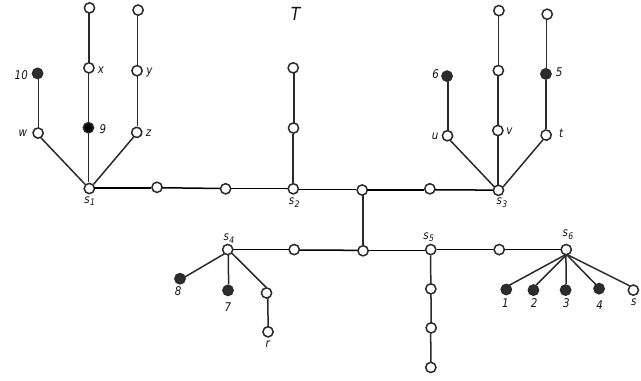
Figure 2. The tree example T with β ( T ) = 10 and β (cid:48) ( T ) = 14. For y ∈ V Γ and f = ab ∈ E Γ , the vertex-edge metric/distance is determined as d ( y , f ) : = min { d ( a , y ) , d ( b , y ) } . A vertex y ∈ V Γ is known to resolve two edges f , g ∈ E ( Γ ) if we have d ( y , f ) (cid:54) = d ( y , g ) . An edge-resolving set is a set Y = { y k } (cid:96) edges are resolved by some y k ∈ Y ( 1 ≤ k ≤ (cid:96) ) . Symbolized as β e ( Γ ) , the edge